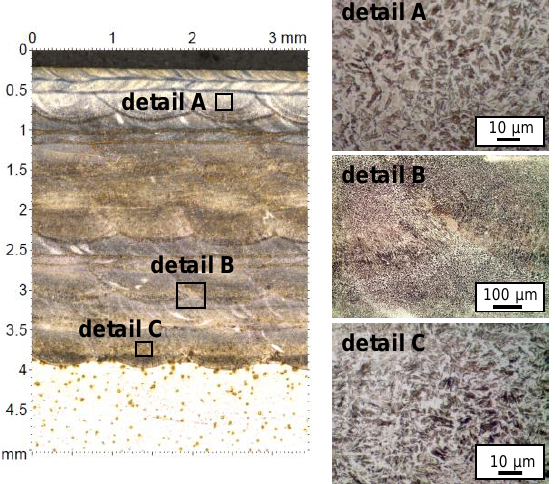
Figure 4. Cross-section of the DED AISI H13 and details of the microstructure.